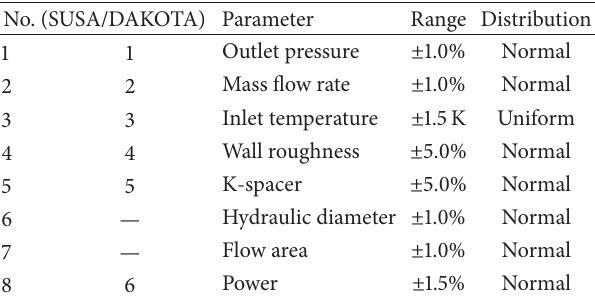
Table 2: Uncertain